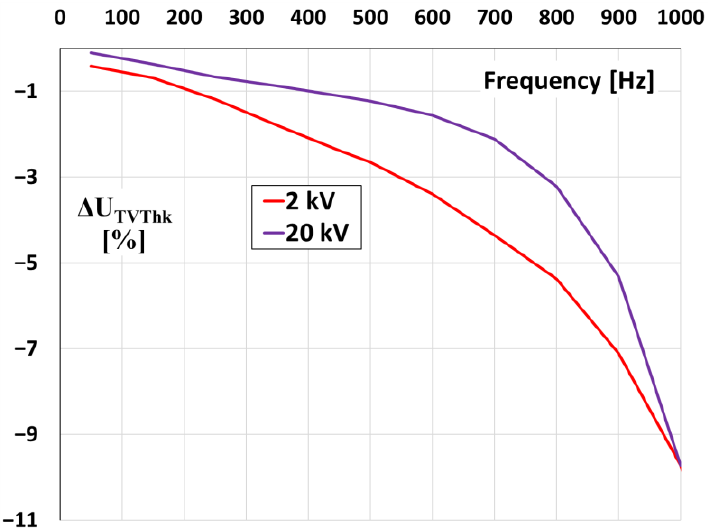
Figure 11. The values of voltage error at harmonics of the 20 kV voltage transformer (model 1) for different levels of primary voltage with a 10% higher harmonic.